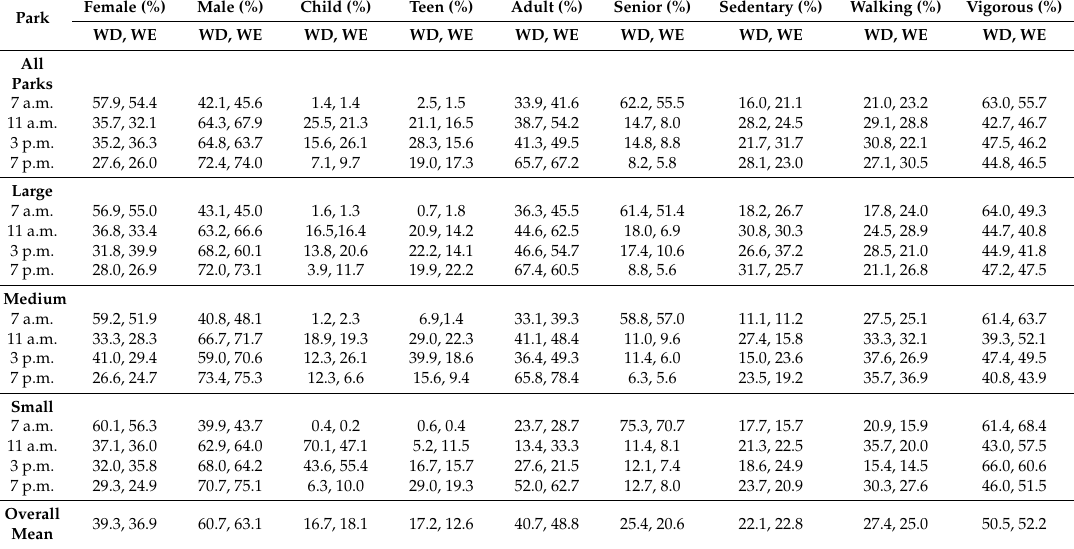
Table 4. Proportion of park users by gender, age group, and physical activity levels for large ( n = 3), medium ( n = 3), and small ( n = 3) parks during four daily time periods on 36 weekdays (WD) and 36 weekend days